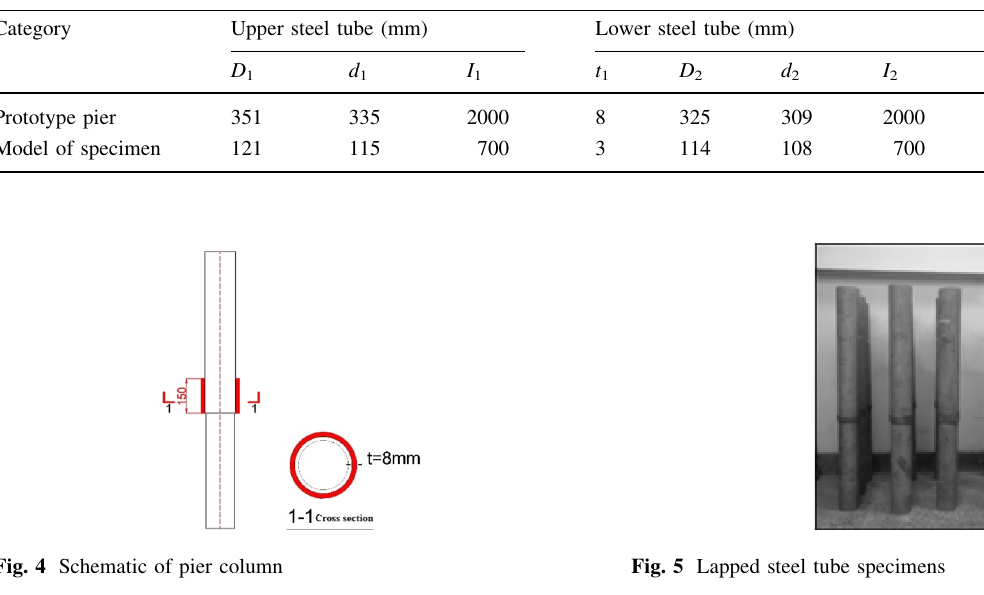
Table 1 Dimensions of original structure and model